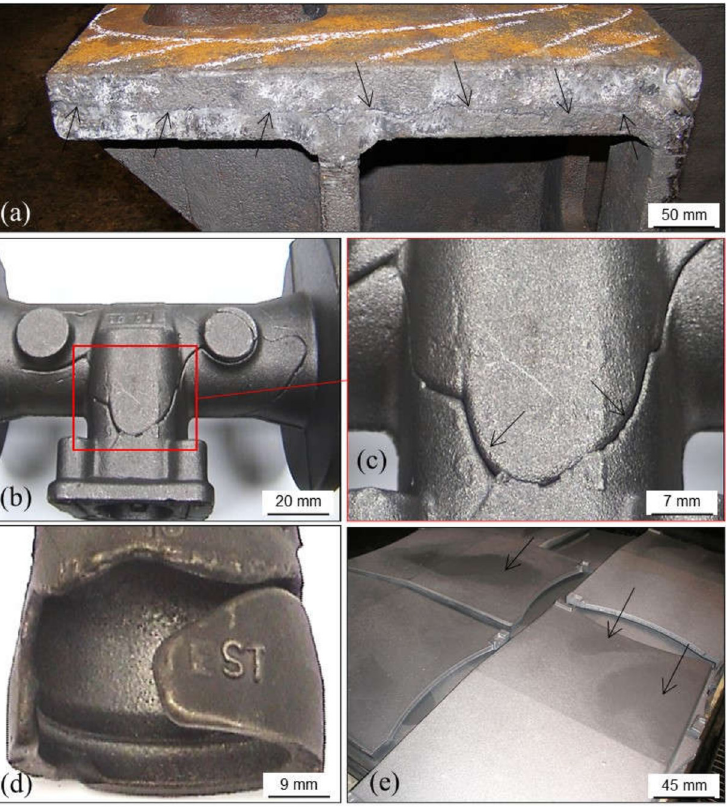
Figure 91. Severe cold shuts found in ( a ) the top area of a heavy-section casting and in a ductile iron valve ( b , c ). Cold shut together with misrun present in a ductile iron casting used for electrical insulators ( d ). Defect variant without discontinuities in grey iron castings used to manufacture ornamental cookers ( e ).